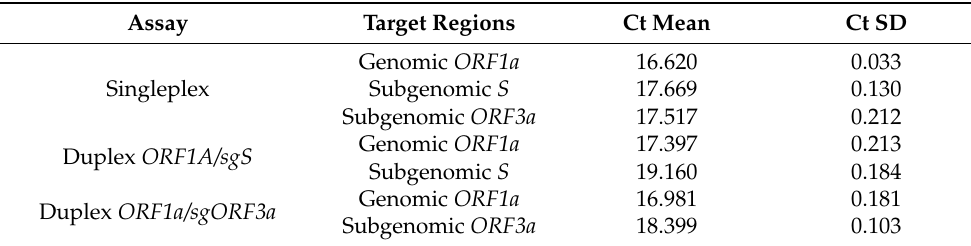
Figure 4. Singleplex RT-qPCR assays specifically detect SARS-CoV-2 genomic or subgenomic nucleic acids. The amplification product after RT-qPCR for genomic ORF1a ( gORF1a ; ( A )), subgenomic spike ( sgS ; ( B )), and subgenomic ORF3a ( sgORF3a ; ( C )). SARS-CoV-2 RNA from supernatants of infected Vero cells (orange) and positive control gene fragment (green), negative non-template control (NTC; blue). The genomic S ( gS ; ( B )), genomic ORF3a ( gORF3a ; ( C )) were used as negative control gene fragments (gold). Amplification curves for the respective product seen on the gel for target gORF ( A ), sgS ( B ), and sgORF3a ( C ) are shown. The experiment was performed thrice, and each reaction was run in triplicate. RT-qPCR = real-time reverse transcription PCR; SARS-CoV-2 = severe acute respiratory syndrome coronavirus 2. Table 2. Ct values for singleplex and duplex RT-qPCR assays using supernatant of Vero cells infected with SARS-CoV-2 Washington strain.